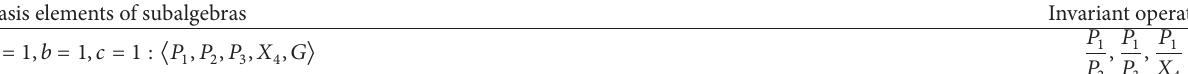
Table 19: Invariant operators of subalgebra of the type 𝐴 𝑎𝑏𝑐 5,7